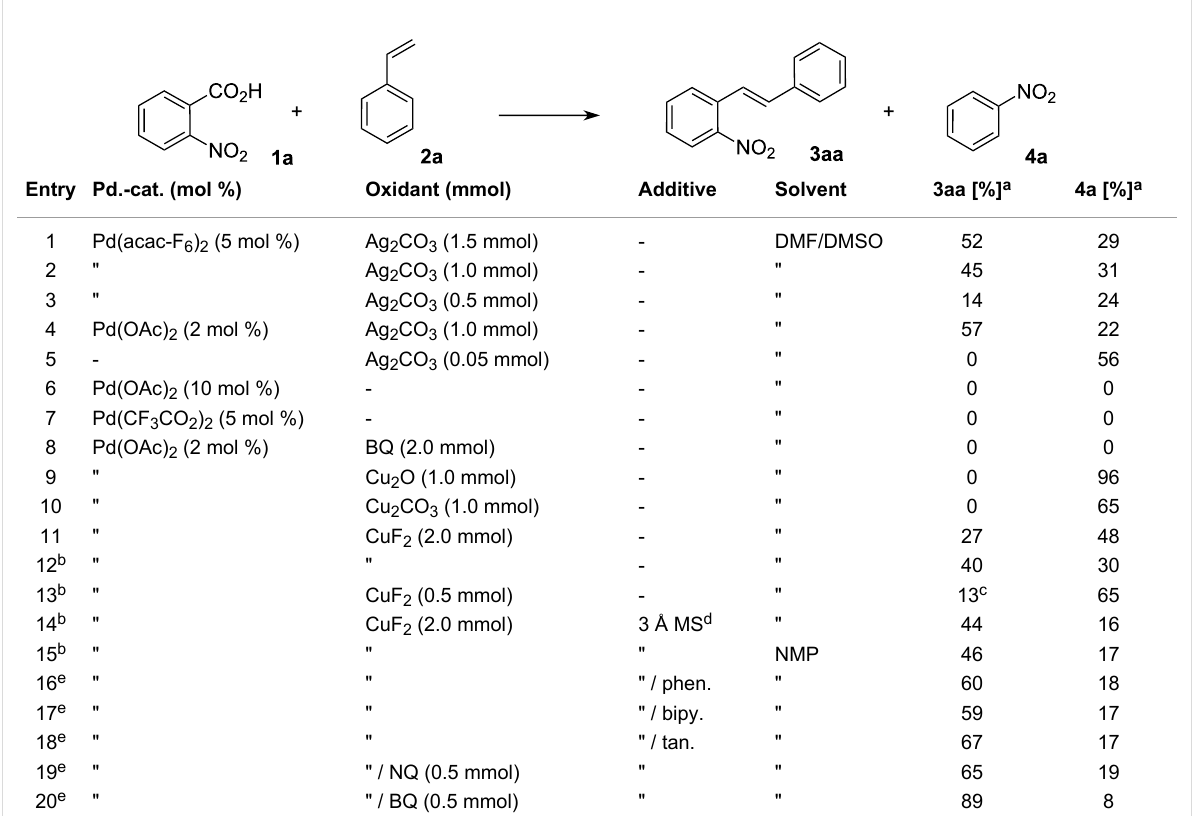
Entry Pd.-cat. (mol %)